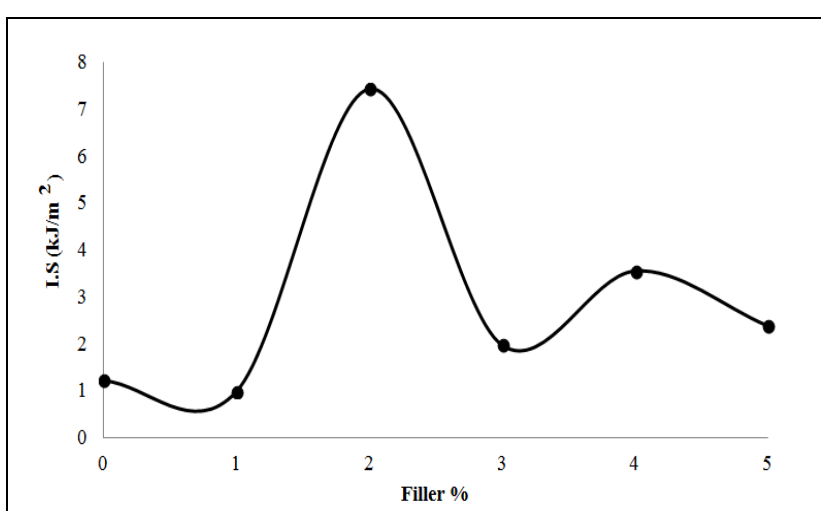
Fig.15: Impact strength with filler for all